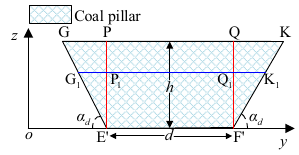
Fig. 3 Spatial shape and force state of supporting coal pillar